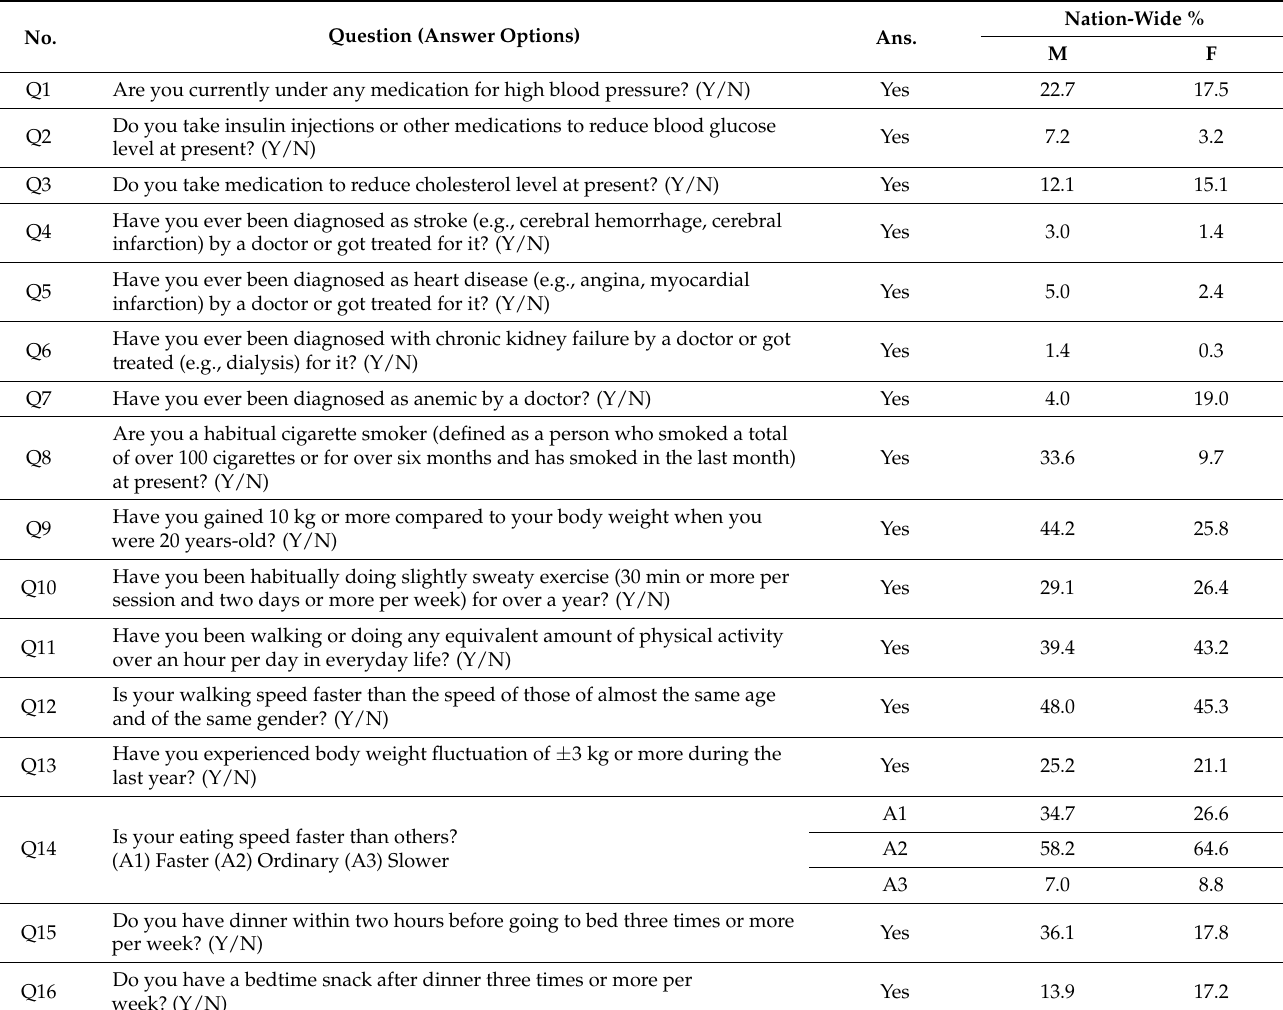
Table 2. Health checkup variables (questions on health